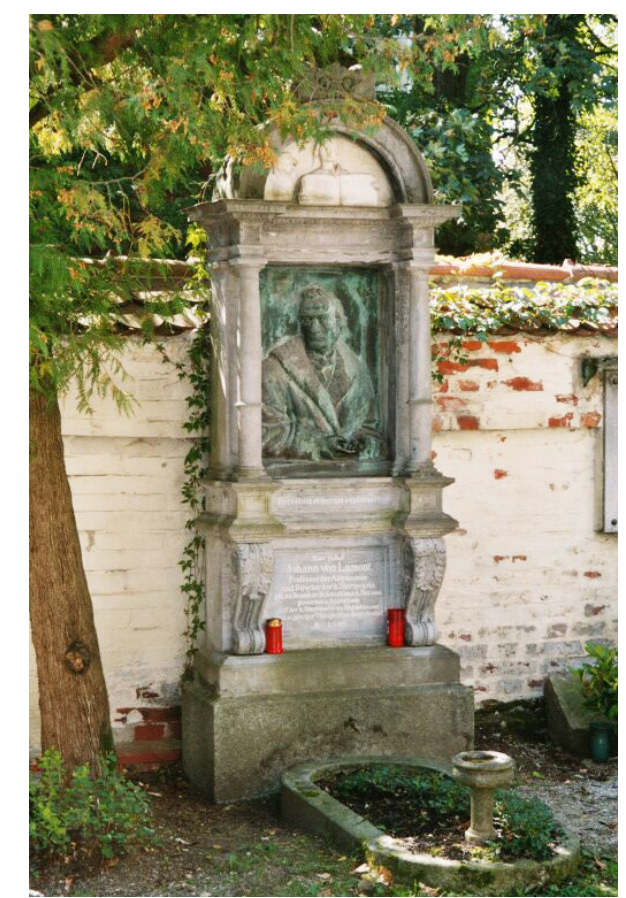
Figure 7. Lamont’s grave in Bogenhausen. It has the incription Et Coelum Et Terram Exploravit – He Explored the Heavens and the